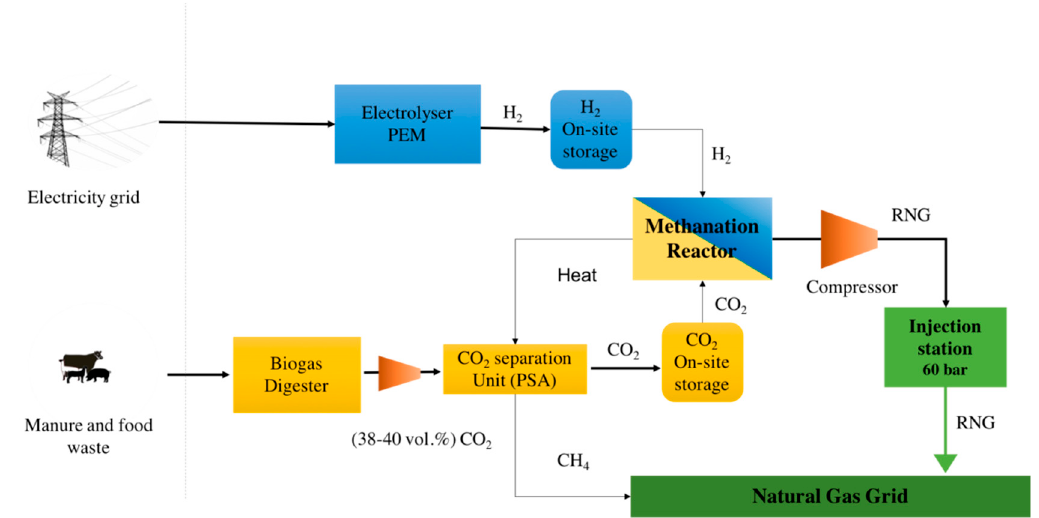
Figure 2. Power-to-Gas-to-renewable natural gas (Methanation) [13,22,23].